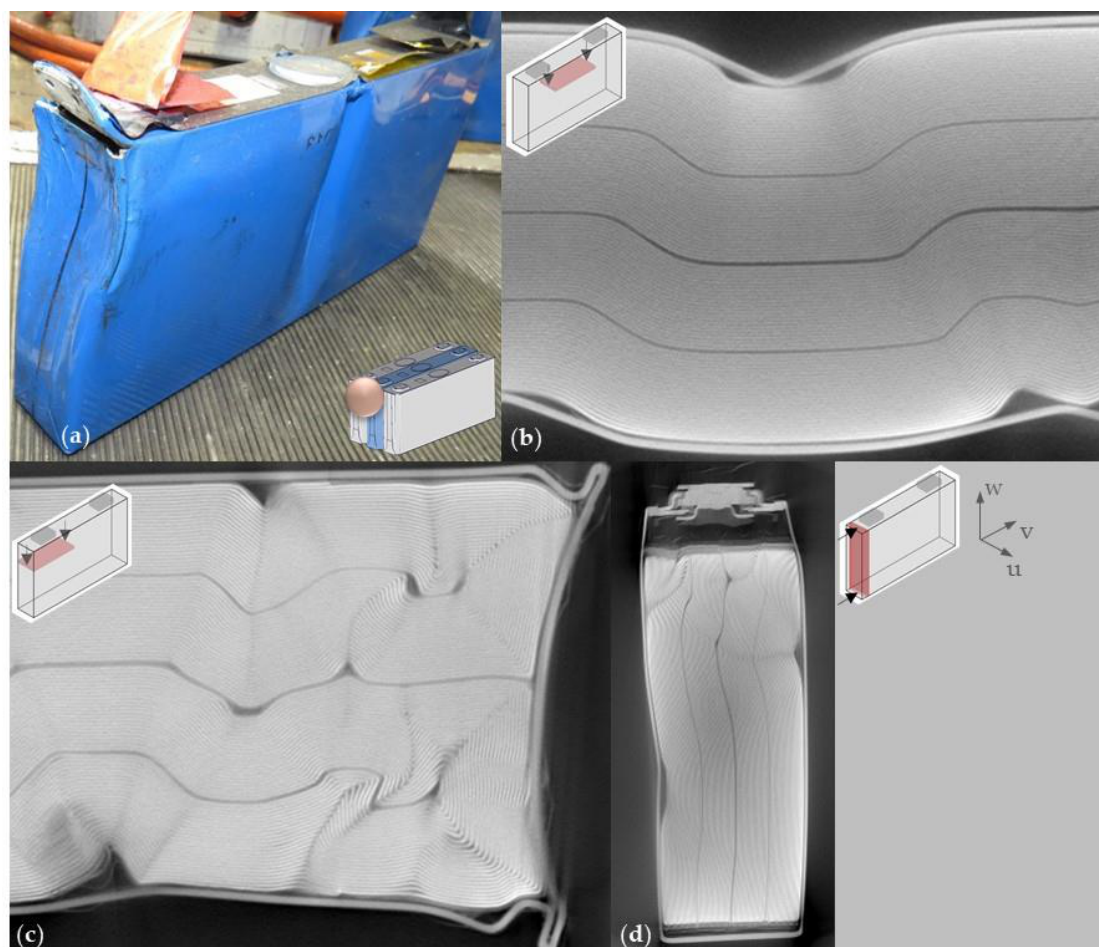
Figure 13. V-direction with hemispherical impactor: ( a ) deformed middle cell; ( b – d ) CT-Scans.